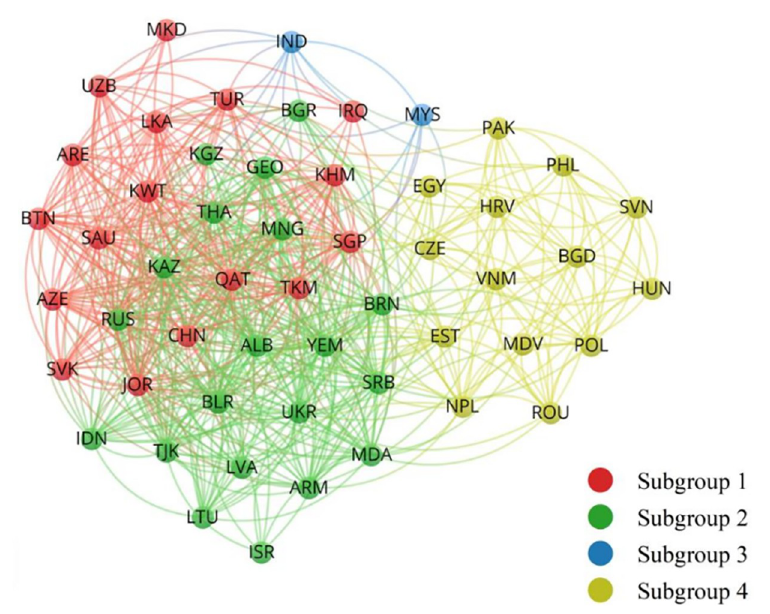
Fig 2. Network subgroups during 2014–2019. Source: Drawn by the authors from VOSviewer software.